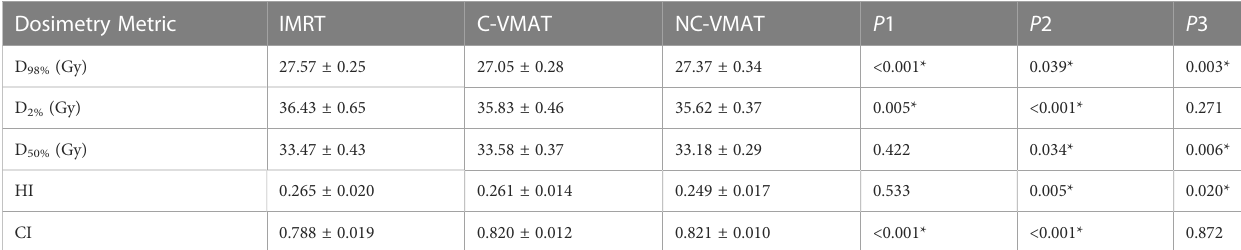
TABLE 4 The dosimetric values (mean ± SD) of WB-PTV under three types of treatments (IMRT, C-VMAT and NC-VMAT) and comparison of the three treatments in terms of dosimetry metric and related p values. Dosimetry